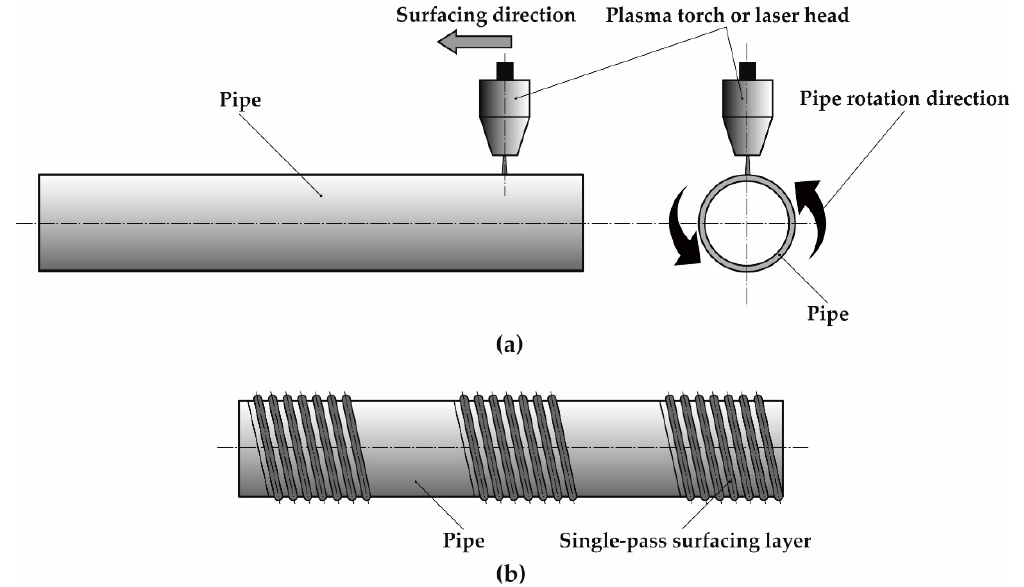
Figure 1. Schematic of outer 16Mo3 steel pipe surface surfacing with nickel ‐ based superalloy Inconel 625: ( a ) movement of plasma / laser head and pipe rotation, ( b ) arrangement of surfacing passes on the pipe surface.